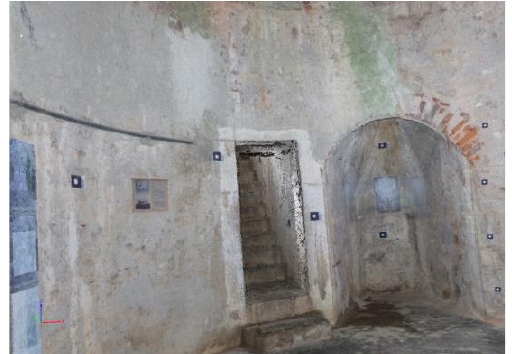
Figure 11: Result of 3D reconstruction for scenario 2 in the fence, presenting similar inconsistencies in case 1.